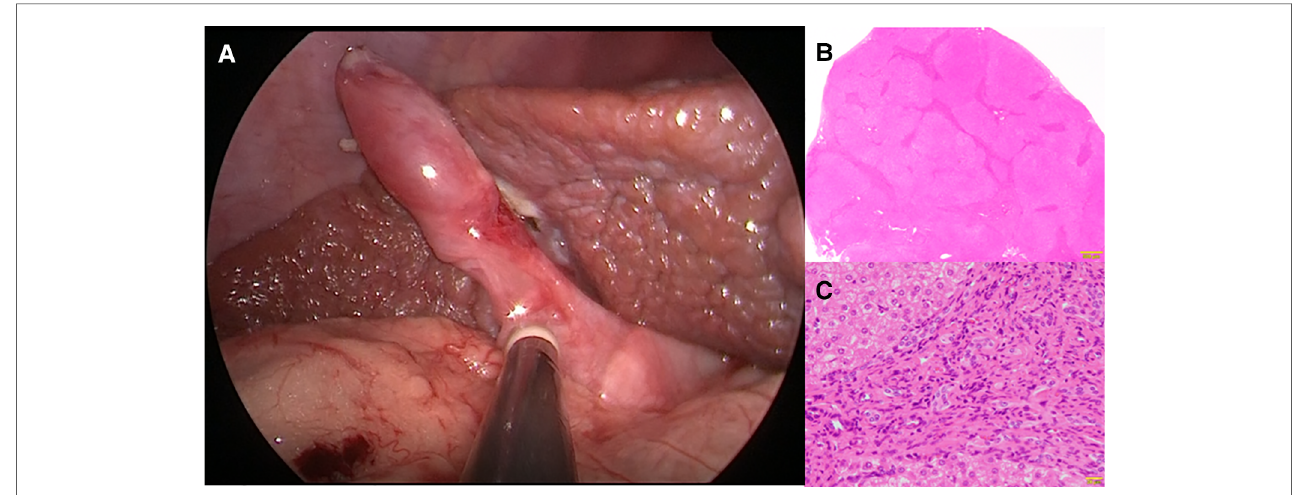
FIGURE 2 Histopathological fi ndings at hepaticojejunostomy. Chronic hepatitis and fi brosis, F3, A2. ( A ) Intraoperative fi ndings ( B ) An enlarged portal area and bridging fi brosis were observed (Hematoxylin Eosin staining ×10). ( C ) Proliferation of regenerated bile ducts and the in fi ltration of neutrophils and lymphocytes were observed (Hematoxylin Eosin staining